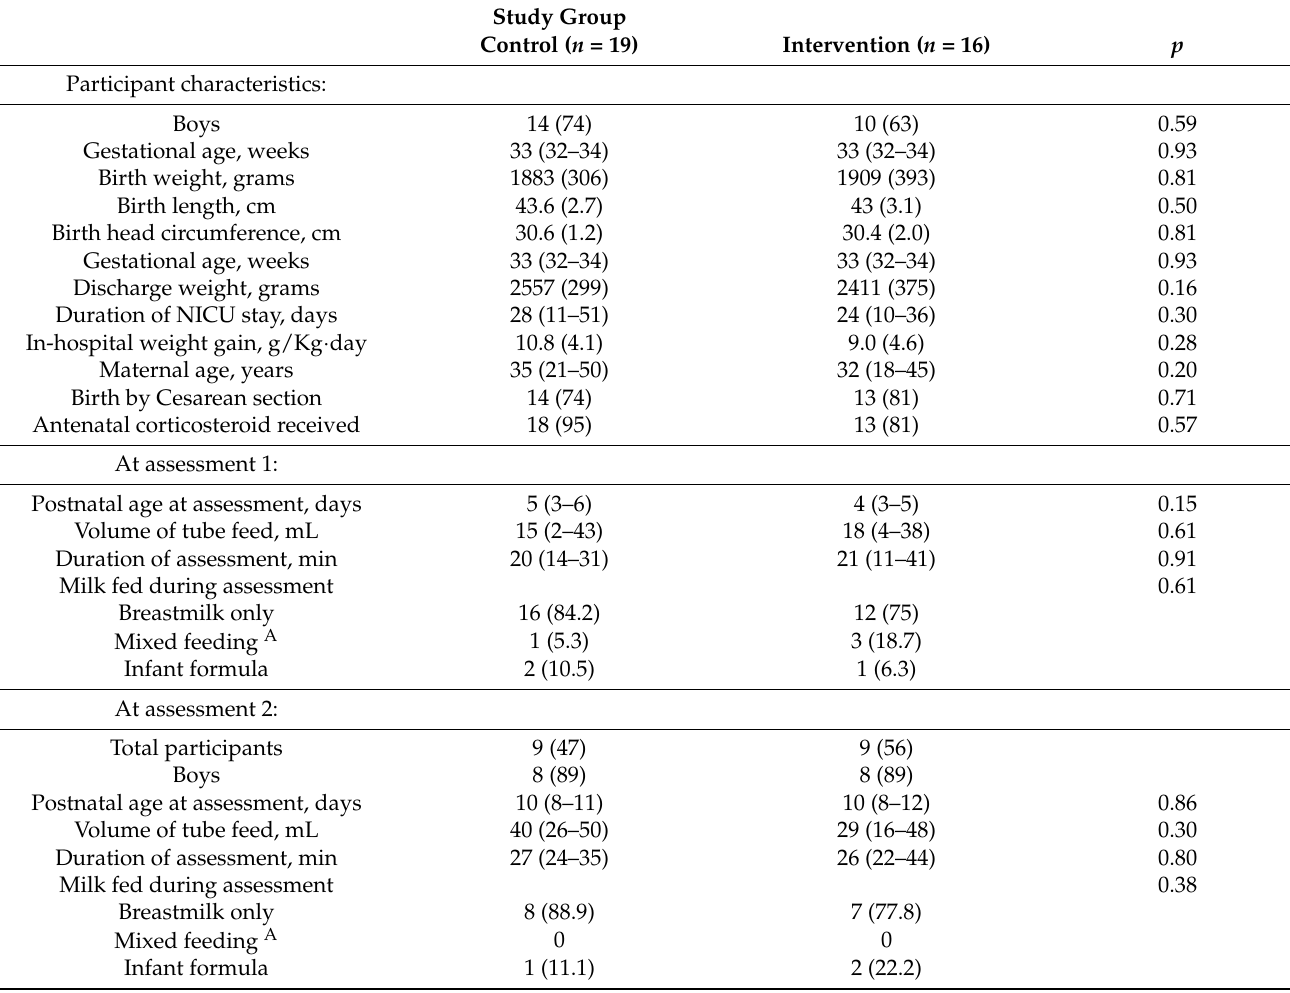
Table 1. Study groups’ characteristics.